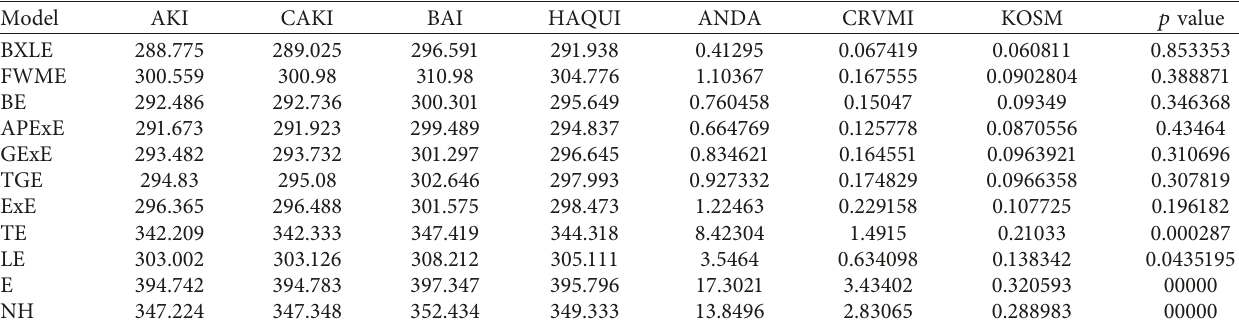
Table 12: Discrimination measures of the BXLE model and other competing models for second dataset. Model